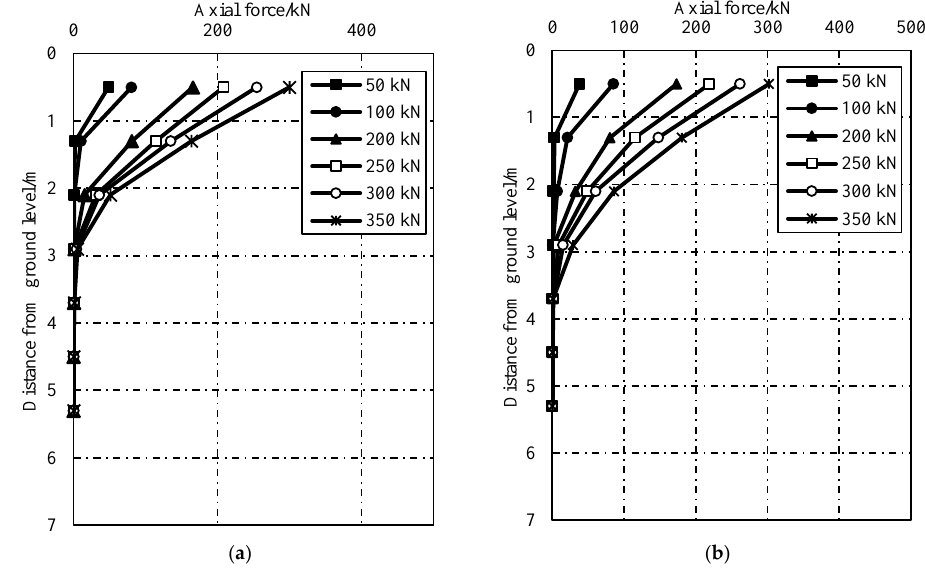
Figure 6. Axial forces versus depth: ( a ) GFRP-1 and ( b ) GFRP-2.